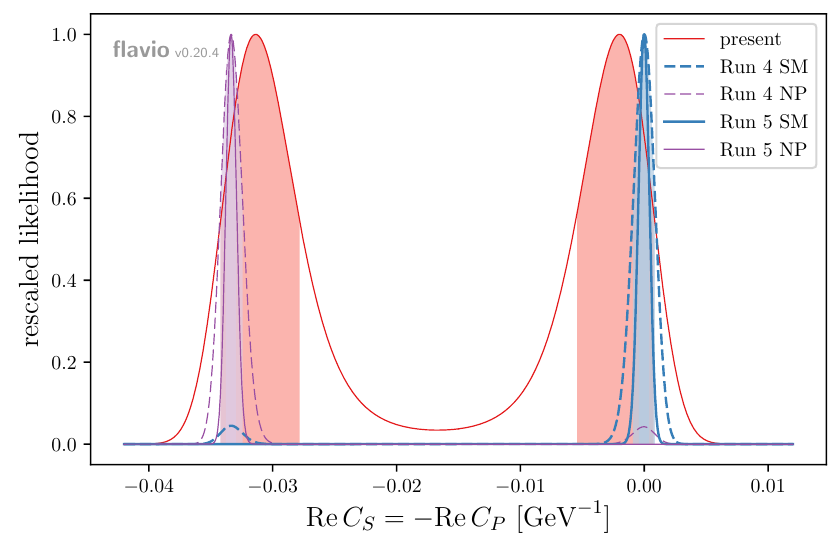
Figure 2 . Present and future constraints on the real part of the Wilson coe(cid:14)cient C to satisfy the SMEFT relation. The vertical axis corresponds to the likelihood (containing experi- mental and theoretical uncertainties), rescaled to equal maximum likelihood. The scenarios labeled \Run 4" (dashed lines) correspond to eq. (3.6a), \Run 5" (solid lines) to eq. (3.6b). The \NP" scenario (thin lines) predicts the same branching ratio as in the SM (thick lines), but opposite A (cid:1)(cid:0) . The shaded ranges correspond to 1 (cid:27) (highest likelihood regions containing 68 : 3% of the integrated